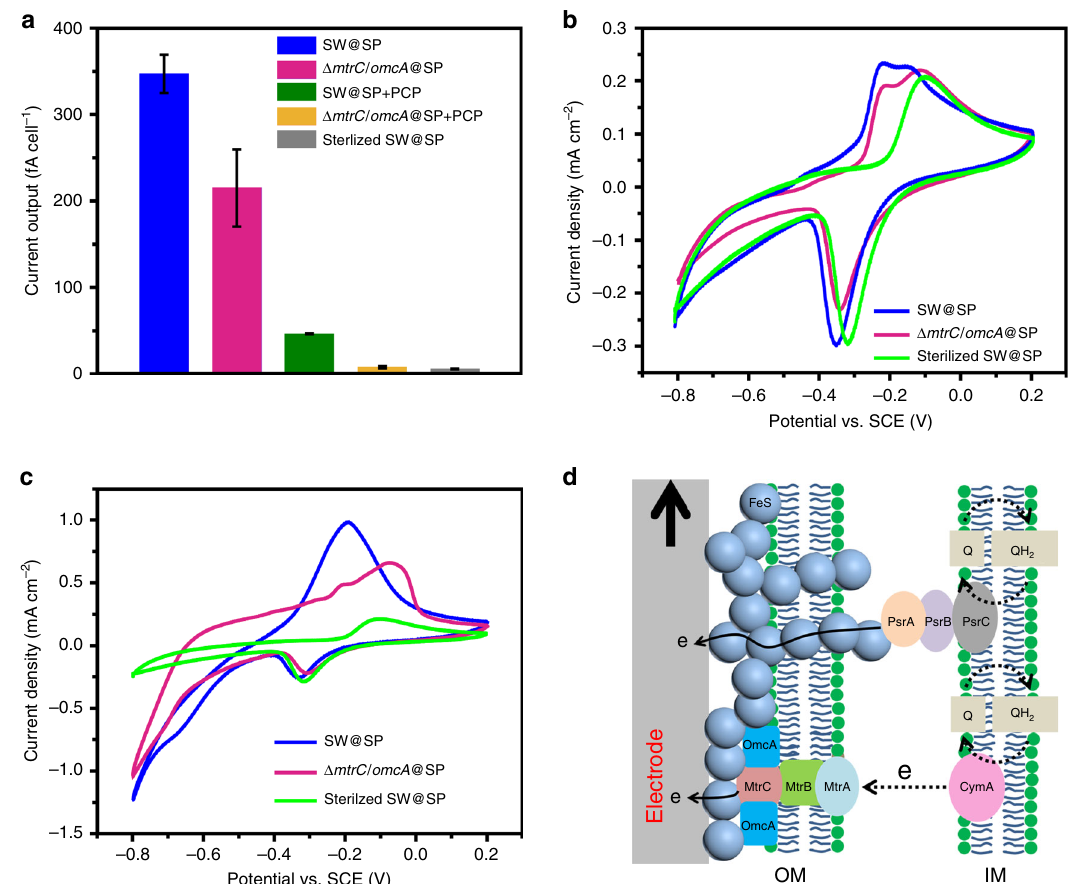
Fig. 5 Wiring up of cellular conduits with a solid electrode by the SP collector. a Current output of an cell@SP cell under different conditions ( n = 3). PCP (2mgL − 1 , PsrC inhibitor) was added to SW@SP or Δ mtrC/omcA @SP cells at 2 h before electrochemical test. Error bars represent standard error (s.e.) determined by three independent experiments. b , c CV curves of SW@SP cells under non-turnover and turnover conditions with a scanning rate of 1mVs − 1 . d Proposed electron transfer pathway for the SW@SP cell with an electrode. Table 1 Performance of BES with native cells or cells with different single cell electron